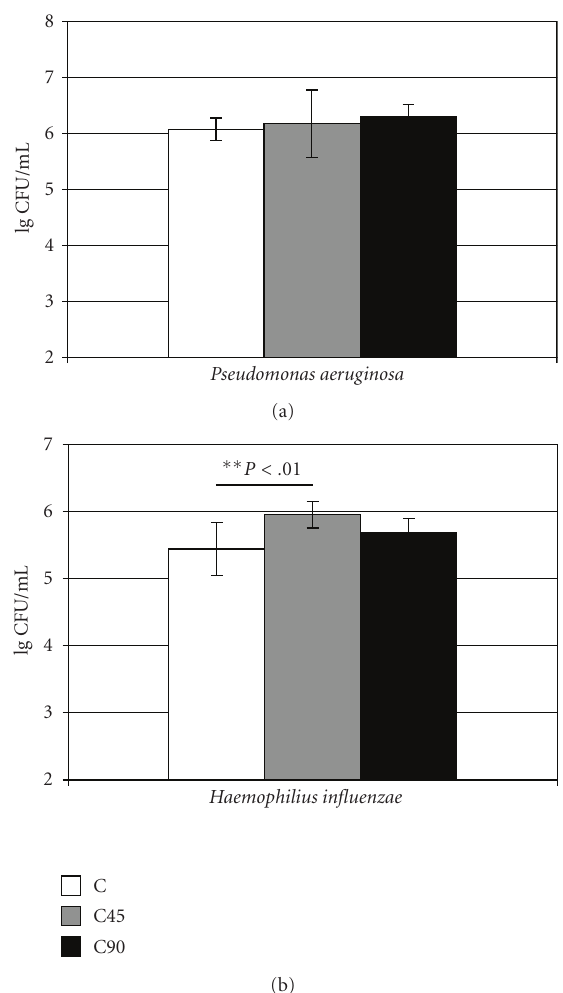
Figure 2: Early colonization (lg CFU/mL) by P. aeruginosa (ATCC 27853) and H. influenzae (ATCC 49247) on the experimental materials C, C45, and C90.